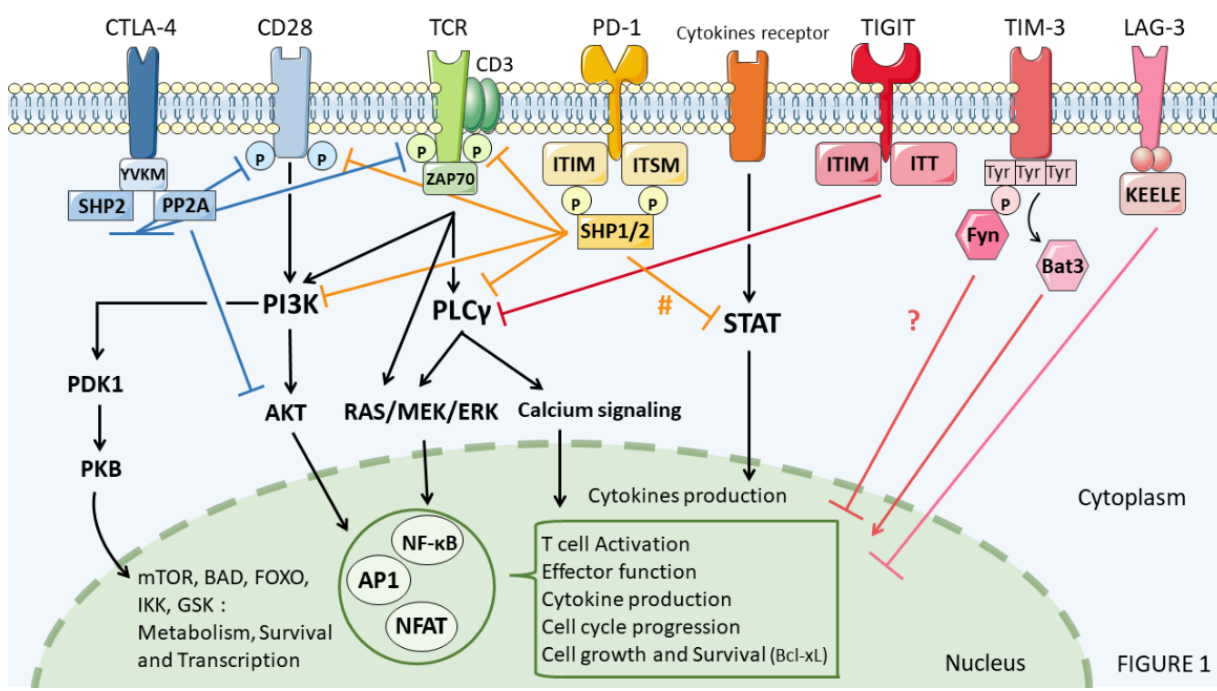
Figure 2. Immune checkpoint signaling in immune cells. # STAT inhibition after PD-1 recruitment remains to be carefully addressed.